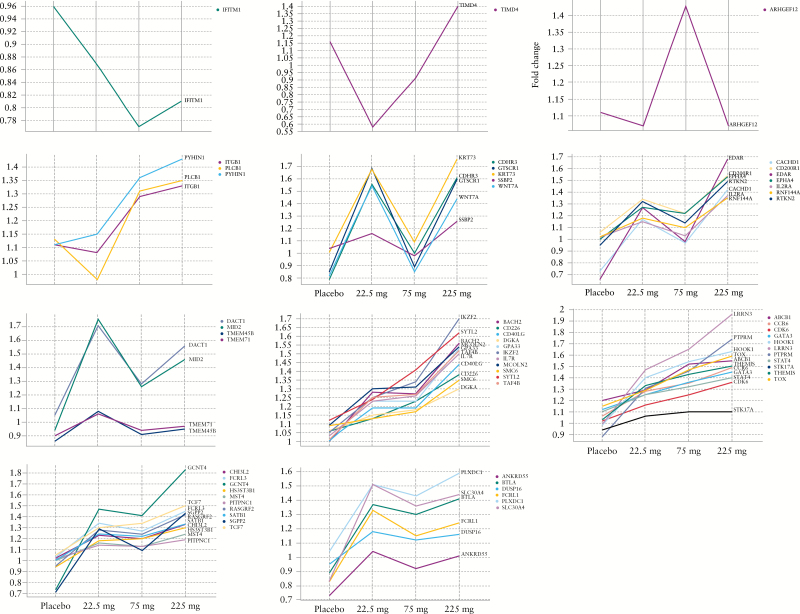
Expression profile of TReg-cell–related genes across treatment arms, ie in placebo, and PF-00547659 22.5-mg, 75-mg, and 225-mg groups, at Week 12. TReg, T regulatory cells.